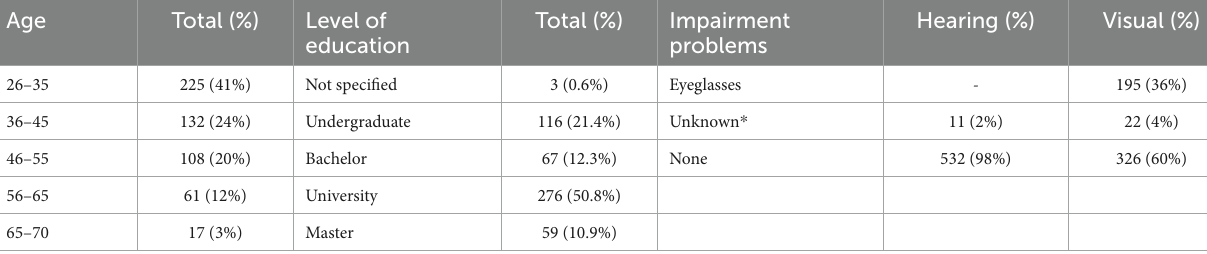
TABLE 1 Socio-demographic information ( N =